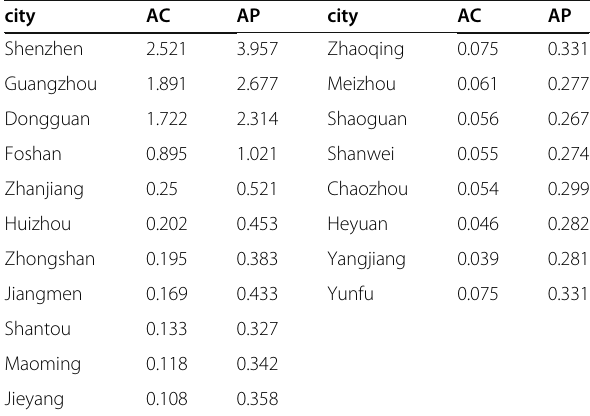
Table 3 Alter-based Centrality and power of cities city